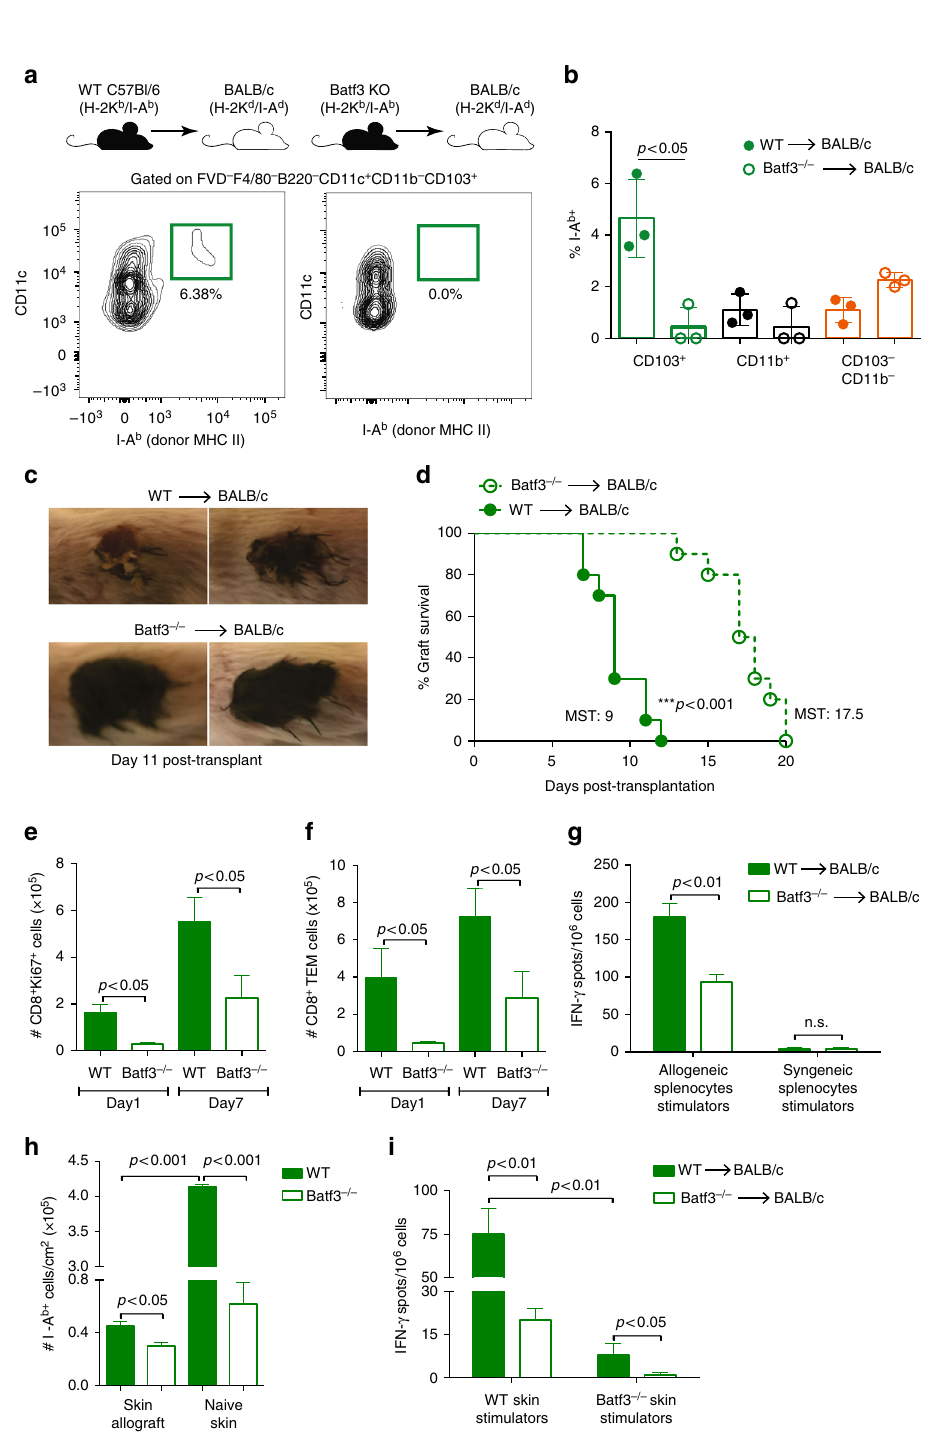
Fig. 1 CD103 + DCs is the major subset carrying allo-MHC II. a Detection and quanti fi cation of I-A b + events in total dLN cells (ungated) of BALB/c mice (H- 2K d /I-A d ) that received allogeneic B6 skin grafts (H-2K b /I-A b ), 24 h post-transplant. b Detection of I-A b + events in dLN of BALB/c mice (H-2K d /I-A d ) that received syngeneic skin grafts (H-2K d /I-A d ) or B6 mice (H-2K b /I-A b ) that received syngeneic skin grafts (H-2K b /I-A b ), 24 h post-transplant. c Representative contour plot and quanti fi cation of live ( fi xable viability dye − ) DCs (CD11c + ) cells in I-A b + population in dLN of BALB/c mice (H-2K d /I-A d ) that received allogeneic B6 skin grafts (H-2K b /I-A b ) overtime. Results are pooled from eight experiments ( n = 11 – 32 mice per time-point/group). d Phenotype and quanti fi cation of CD103 + CD11b-, CD103 − CD11b + and CD103 − CD11b − DC subsets pre-gated on I-A b + FVD − CD11c + population. Statistics using ANOVA with Tukey post-test ( n = 3 – 7 mice per time-point/group). Results are pooled from two experiments. e Absolute numbers of I-A b + CD103 +